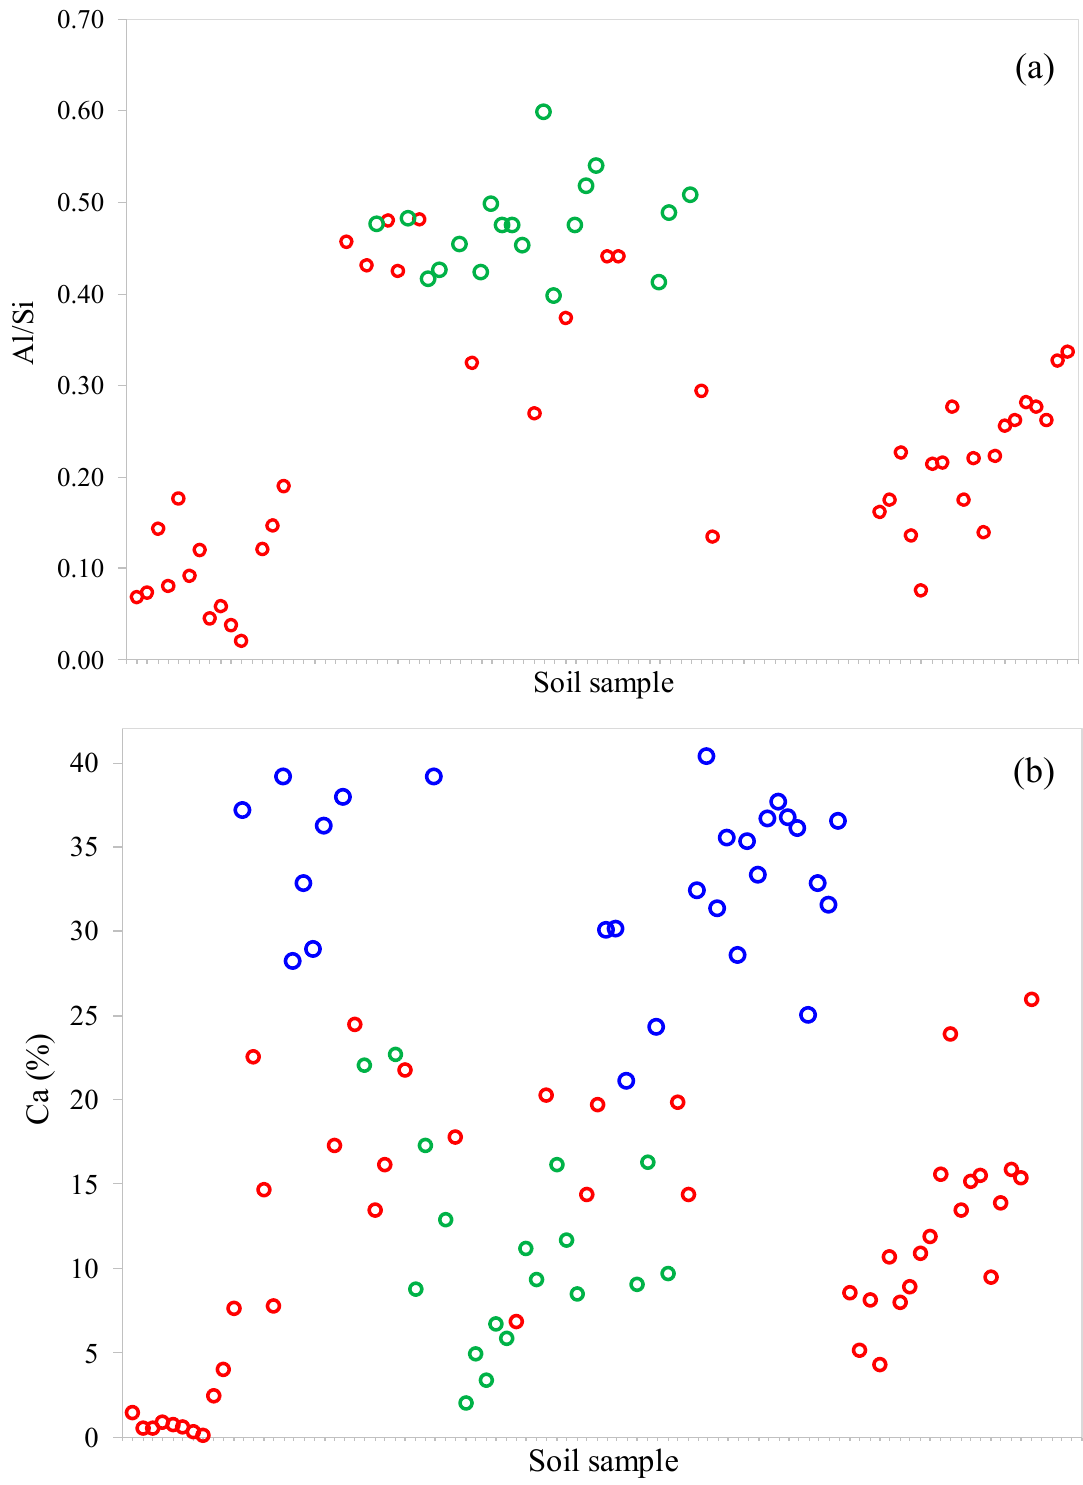
Figure 6. The Al / Si value ( a ) and % Ca ( b ) of each soil sample; red circles represent spectral-based Q-type soils, green circles represent spectral-based CM-type soils, and blue circles represent spectral-based C-type soils.